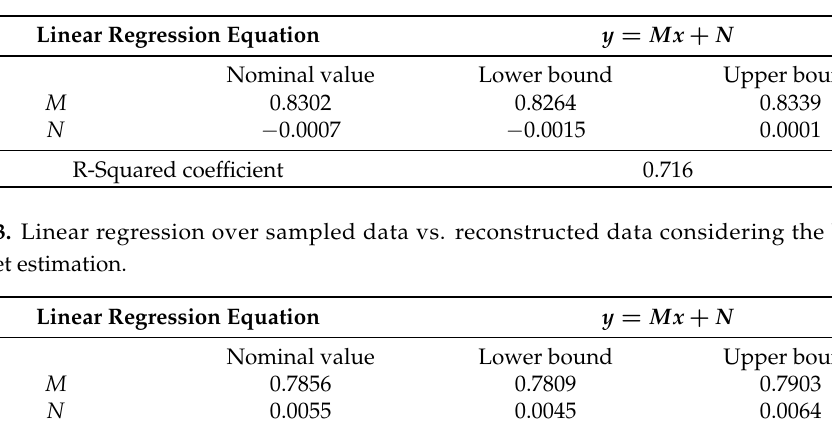
Table 2. Linear regression over sampled data vs. reconstructed data considering the proposed PRESTO estimation.